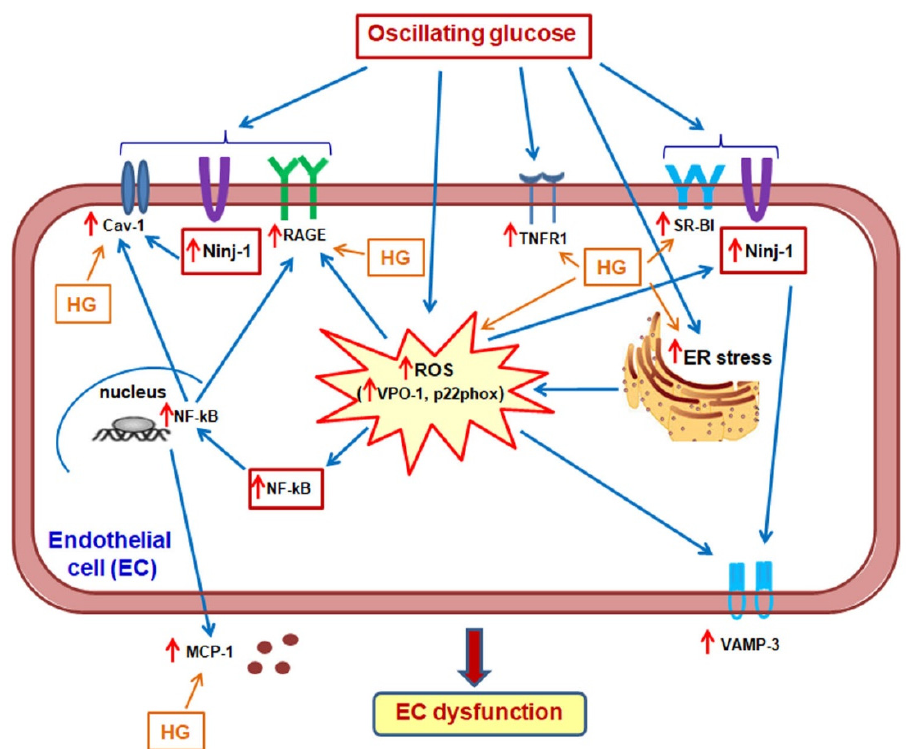
Figure 11. Proposed mechanisms by which oscillating glucose (OG) generates EC dysfunction (ECD). OG determines advanced ECD through a complex process: (1) it enhances intracellular inflammatory stress, determining an increase of Ninj-1, MCP-1 and monocyte adhesion; (2) it stimulates the expression of RAGE and TNFR1; (3) it promotes the up-regulation of SR-BI and VAMP-3, the proteins involved in LDL transendothelial transport, an important process in atheroma formation. These processes are stimulated through mechanisms dependent on the increase of oxidative stress (through VPO1 and p22phox stimulation) and the nuclear translocation of NF-kB. Importantly, Ninj-1 seems to play an intermediate role between inflammation and transendothelial